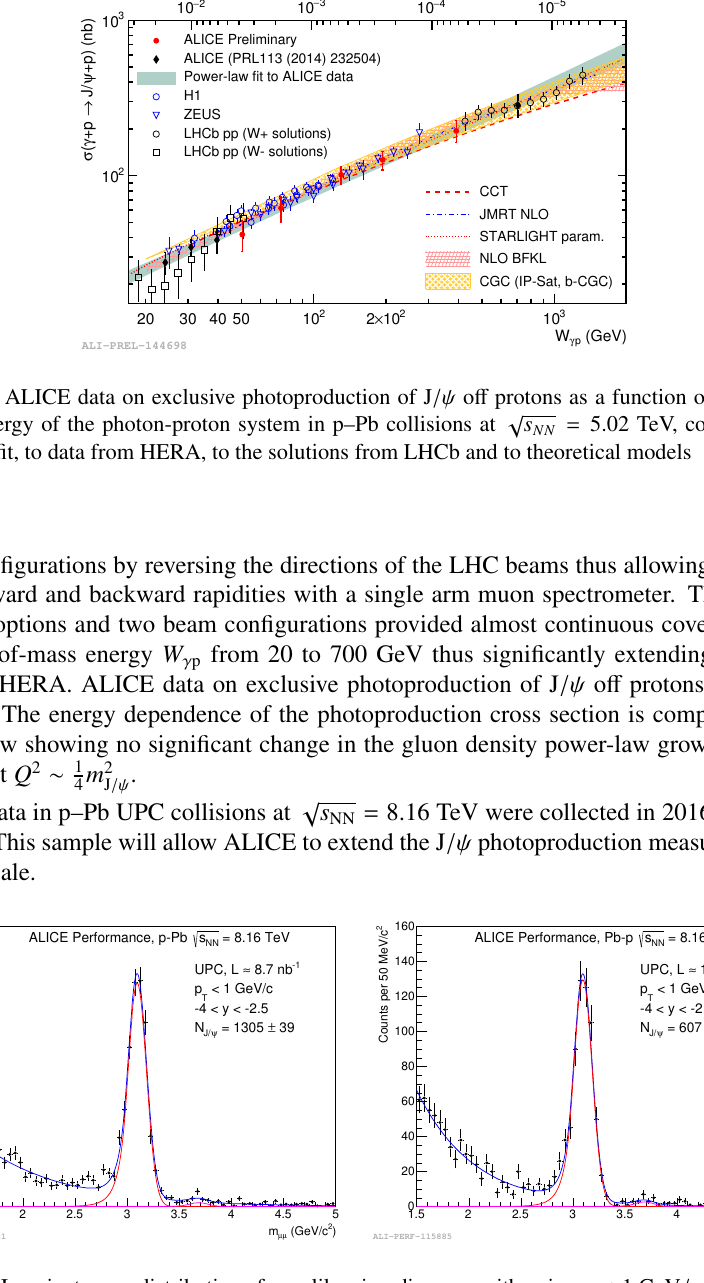
√ s NN = 8 . 16 TeV, cor-